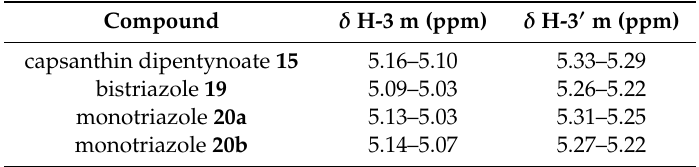
Table 1. Chemical shifts of H-3 and H-3’ in capsanthin dipentynoate ( 15 ), in bistriazole 19 , and in monotriazoles 20a and 20b .